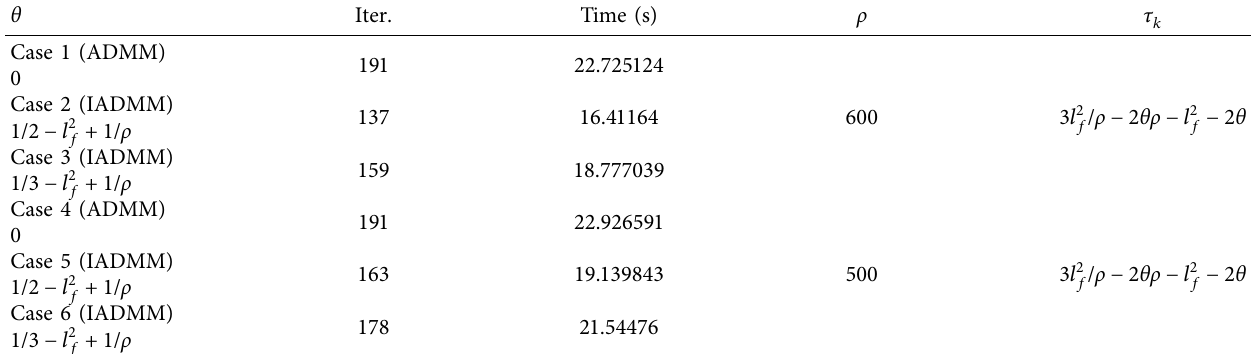
Table 1: Comparison among two algorithms under diferent parameters.